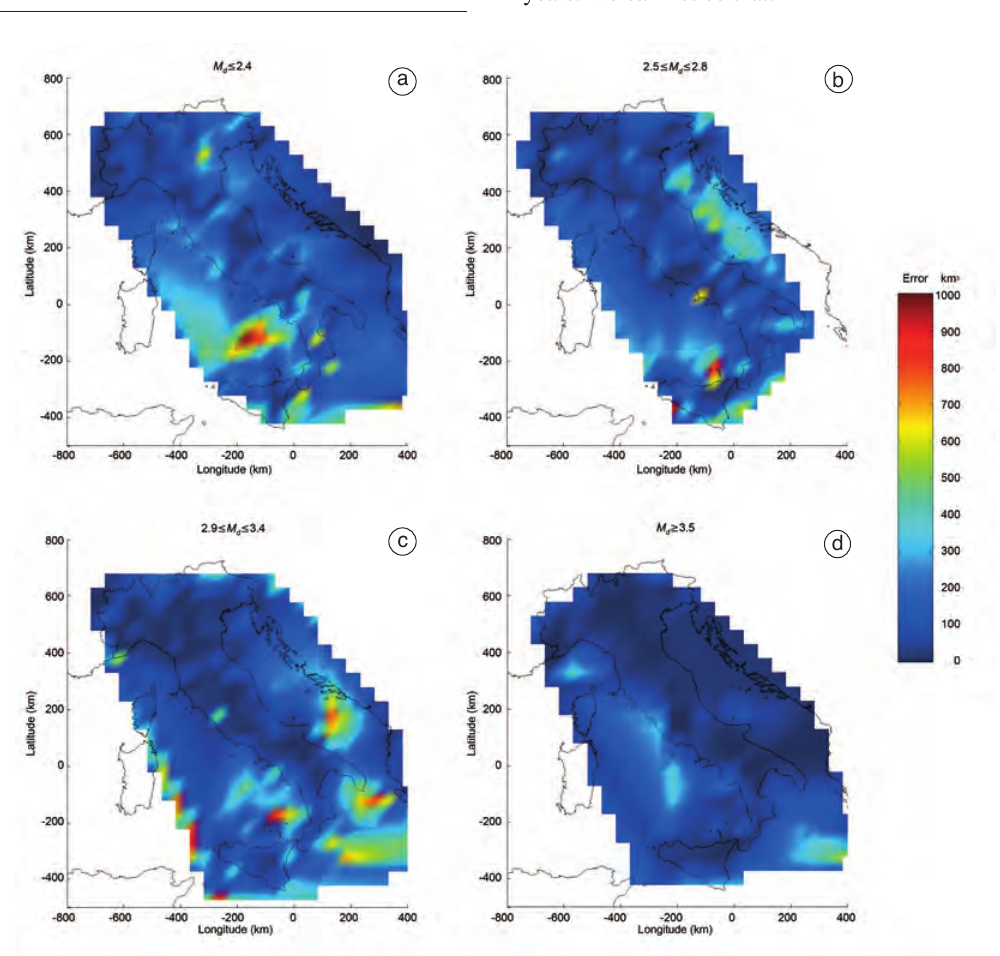
Fig. 13a-d. a) Distribution of the small-medium localization error (below 1000 km 3 ) for events with M d ≤ 2.4. The interpolation is made on a grid of 50 km per side. b) Distribution of the small-medium localization error (below 1000 km 3 ) for events with 2.5 ≤ M d ≤ 2.8. The interpolation is made on a grid of 50 km per side. c) Distri- bution of the small-medium localization error (below 1000 km 3 ) for events with 2.9 ≤ M d ≤ 3.4. The interpolation is made on a grid of 50 km per side. d) Distribution of the small-medium localization error (below 1000 km 3 ) for events with M d ≥ 3.5. The interpolation is made on a grid of 50 km per